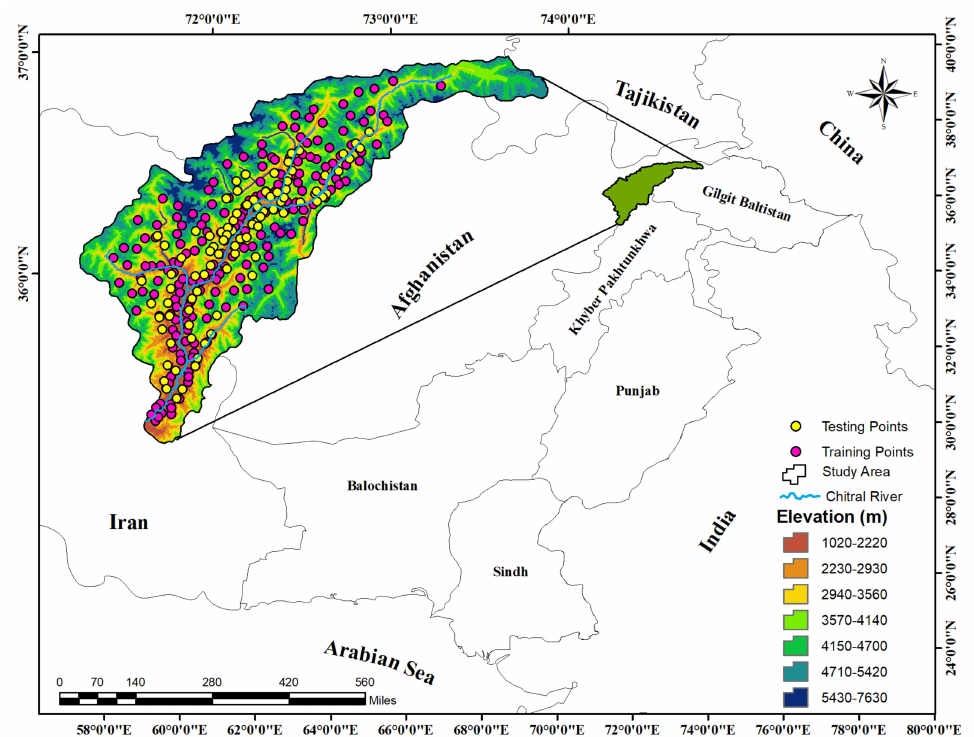
Figure 1. Geo-location of the study area and points show the training and testing points that were used in this